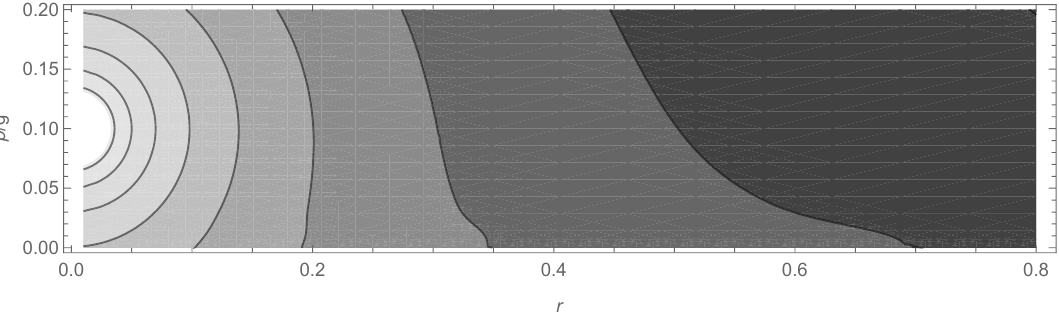
Figure 4 . Equipotential surfaces of a Type III potential.